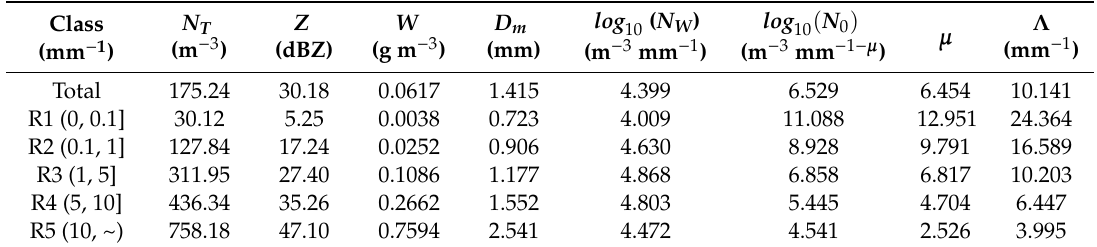
Table 1. Integral rainfall physical quantities derived from the averaged DSDs and the fitted gamma distribution parameters for the five rain-rate regimes.